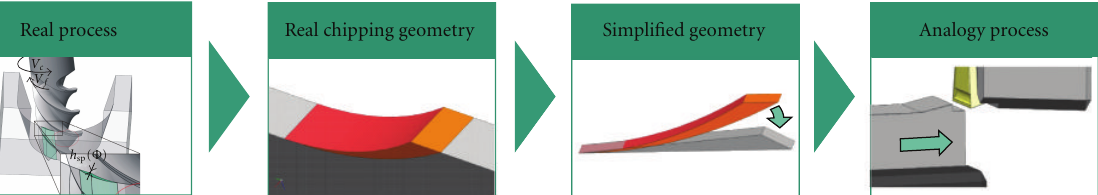
Figure 7: Transformation from the real to the analogy milling process.